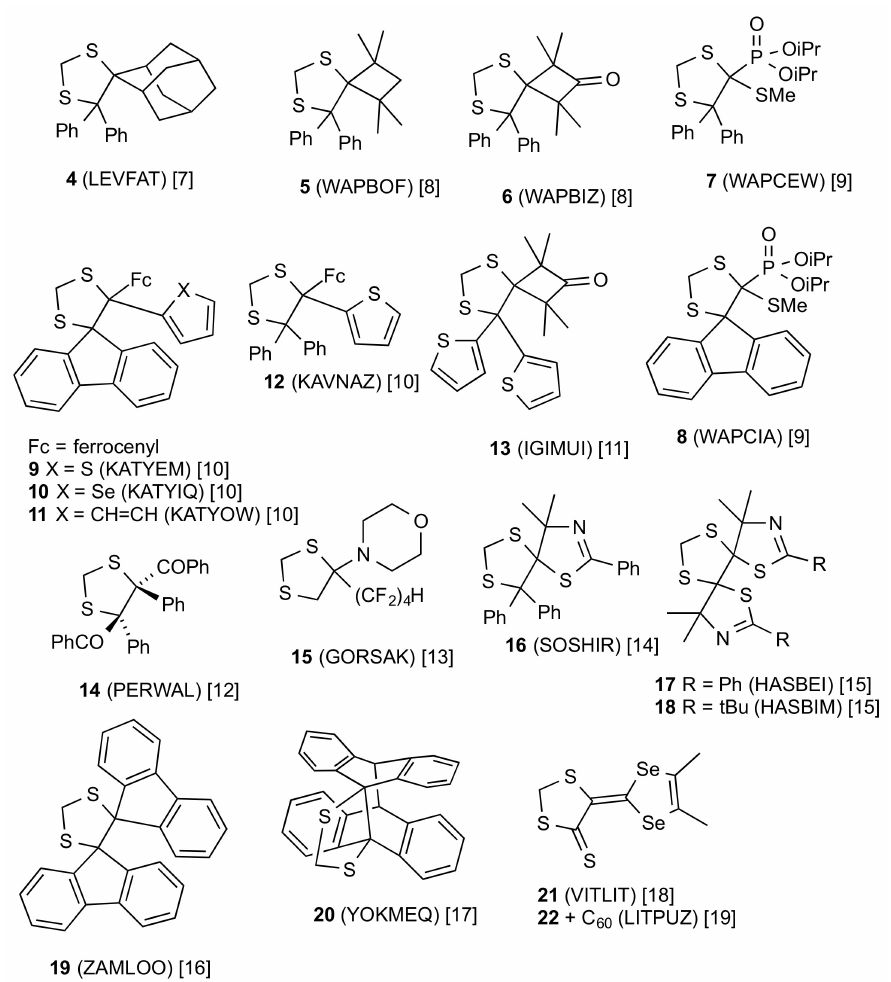
Figure 3. A survey of crystallographically characterised 2-unsubstituted 1,3-dithiolanes with CSD reference codes and literature references